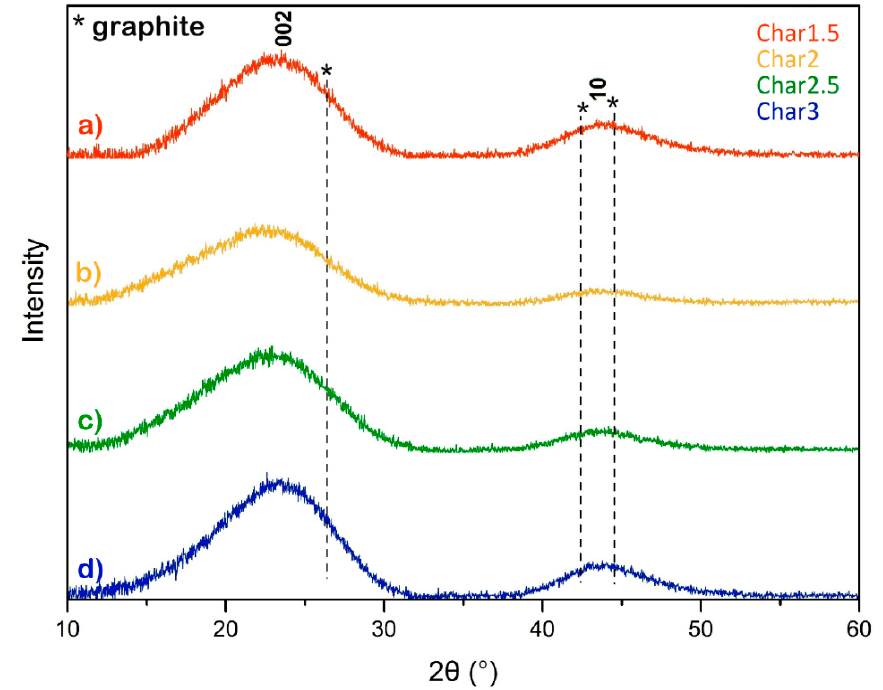
Figure 5. XRD patterns of the nanosponges pyrolyzed at 800 °C and obtained from different PMDA/GLU molar ratios: ( a ) 1.5, ( b ) 2, ( c ) 2.5 and ( d ) 3. XRD positions of graphite plane positions are reported for comparison and marked *.